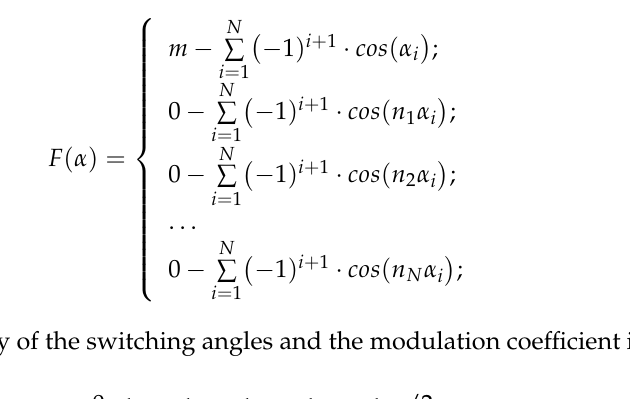
Figure 7. The AFE control system forms the modulation index m and angle θ . The modulation index is sent to the module with the pre-calculated switching angles, and the module produces the switching angles to be compared to the sawtooth carrying signal. The compar- ison is performed using logical Expressions (5)–(7). Logical expressions are a condition